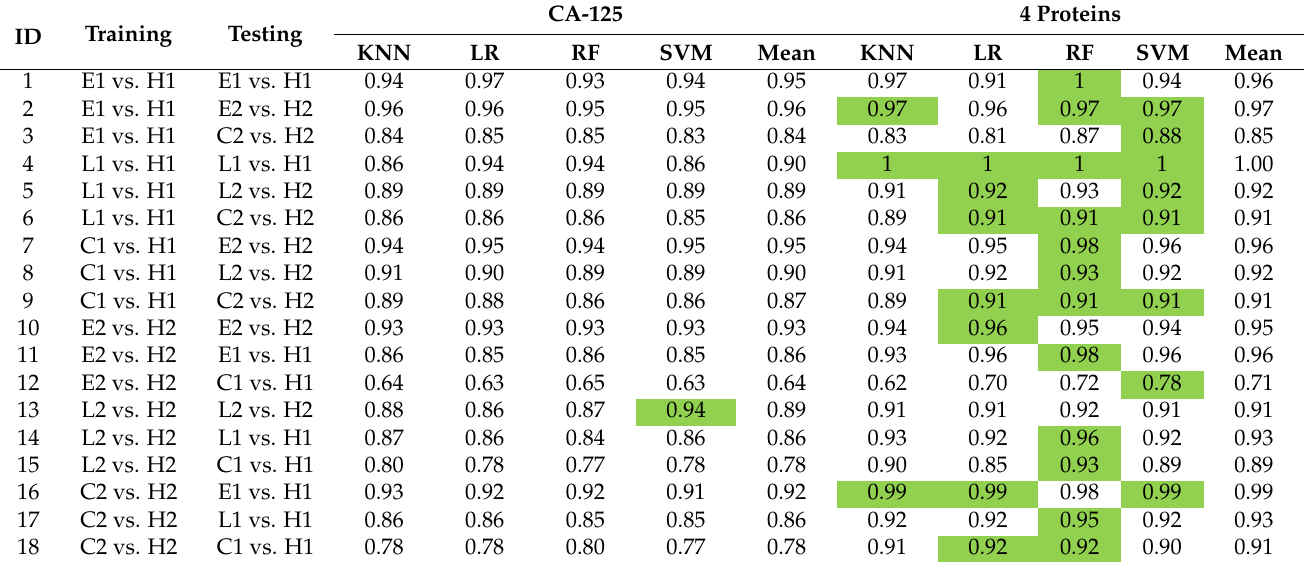
Table 6. The comparison of negative predicted value (NPV) between CA-125 alone and all four proteins (CA-125, MIF, OPN, and PROL) when using four classification techniques, namely K-Nearest Neighbor (KNN), Logistic Regression (LR), Random Forest (RF), and Support Vector Machine (SVM), in various experiments. The NPV measures the liability of a negative test result and is defined as the ratio of the number of control samples correctly identified to the total number of negative test results. We highlighted the cell(s) with best NPV in each experiment. In general, using random forest and all four proteins yield the best results on most occasions.